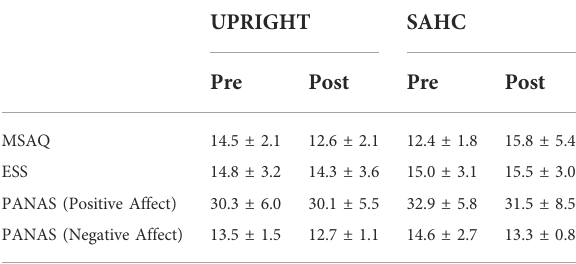
TABLE 2 Motion Sickness (MSAQ), Positive and Negative Affect Schedule (PANAS), and Epworth Sleepiness Scale (ESS) scores prior to (BASELINE) and following the upright (UPRIGHT) and short arm human centrifugation conditions when rotated both clockwise (CLOCKWISE) and counter-clockwise (COUNTER-CLOCKWISE) with 1 g at the participants center of mass when supine. Data as mean